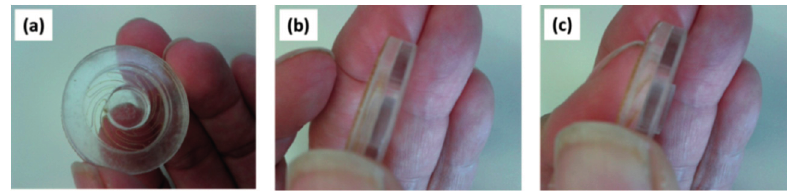
Figure 6. ( a ) Second conceptual applicator with a spiral-spring as a mechanical transducer for displacement of the piston; ( b ) Showing the applicator prior to actuation; ( c ) Showing the applicator in the actuated state.